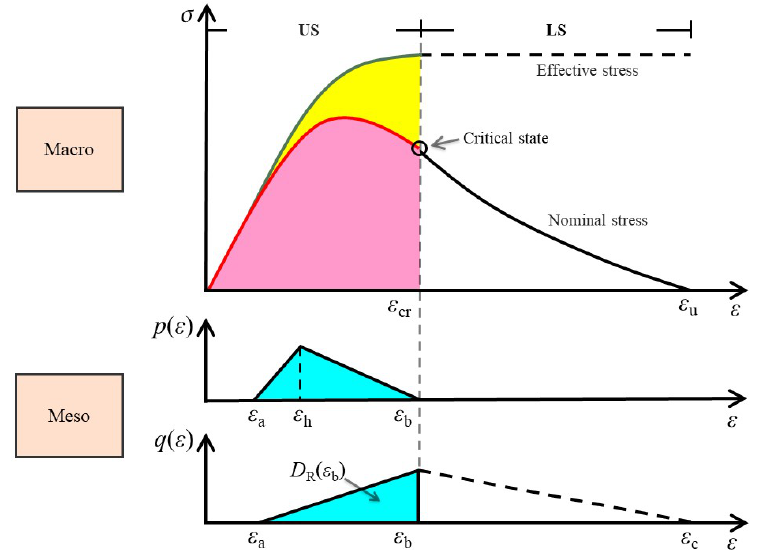
Figure 5. Relationship between constitutive behavior on macro-scale and damage evolution process on